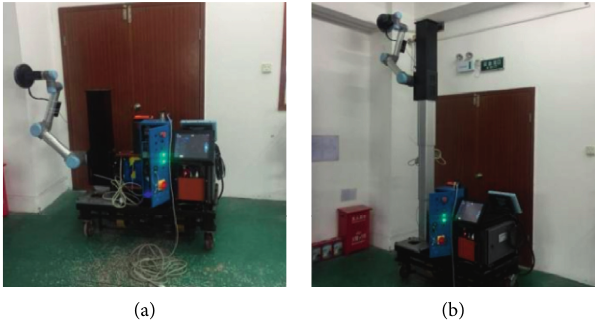
Figure 1: Autonomous decoration robot. The arm of the autonomous decoration robot is used to decorate the walls of rough houses, and a camera sensor on the arm captures environmental image information for the robot.